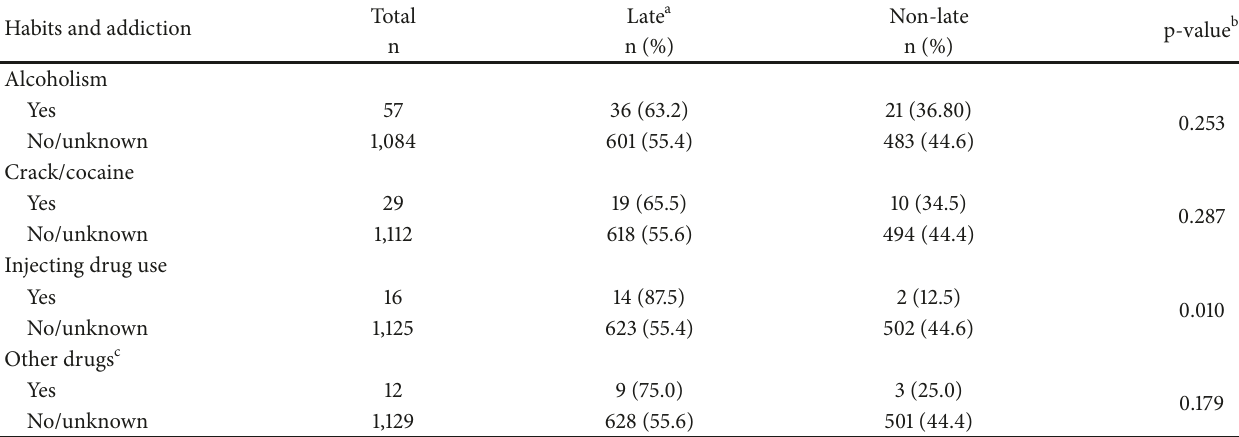
Table 2: Frequency of habits and addiction associated with late initiation of antiretroviral therapy among 1,141 people living with HIV, 2009-